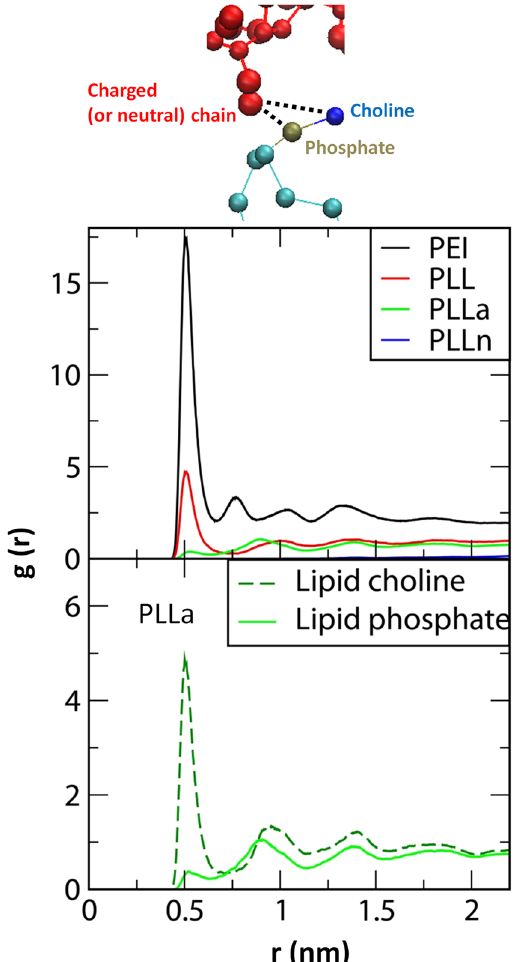
Figure 7. Radial distribution functions between charged (or neutrally mutated) polymer beads and lipid phosphates (top) and between the anionic beads of PLLa and lipid head groups